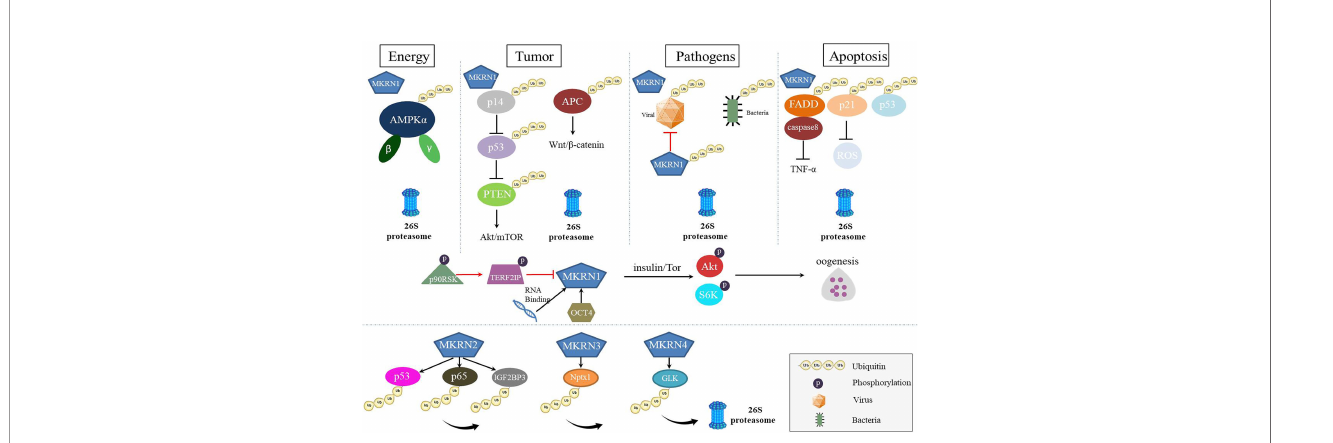
FIGURE 3 | The roles of MKRNs incells. MKRNs (MKRN1, MKRN2, MKRN3, MKRN4) served as E3 ubiquitin ligase play a leadingrolein degrading many substrates and regulating several diseases. MKRN1 regulates energy metabolism,tumor suppression, viralprotein or bacteria ubiquitination,and apoptosis bydegradingtheir substrates. MKRN1 has RNA-binding functions, up-expressed to regulate the insulin signalingpathway duringoogenesis anddown-expressed to regulate the senescence-associated secretory phenotype (SASP).MKRN2, MKRN3, and MKRN4 also mediated substrates ubiquitination and